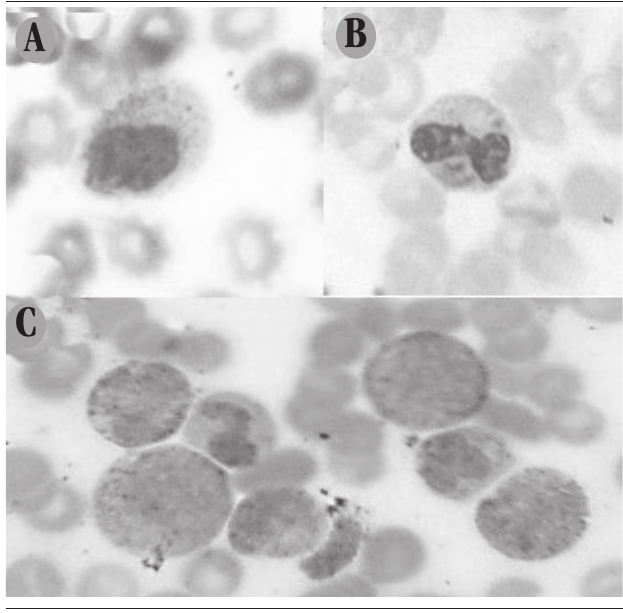
figurE 3 – Photomicrograph of peripheral blood smear Toxic granulation in neutrophils citoplasm (3A and 3B) and normal azurophilic granules in immature granulocytic precursors (3C) (Wright,